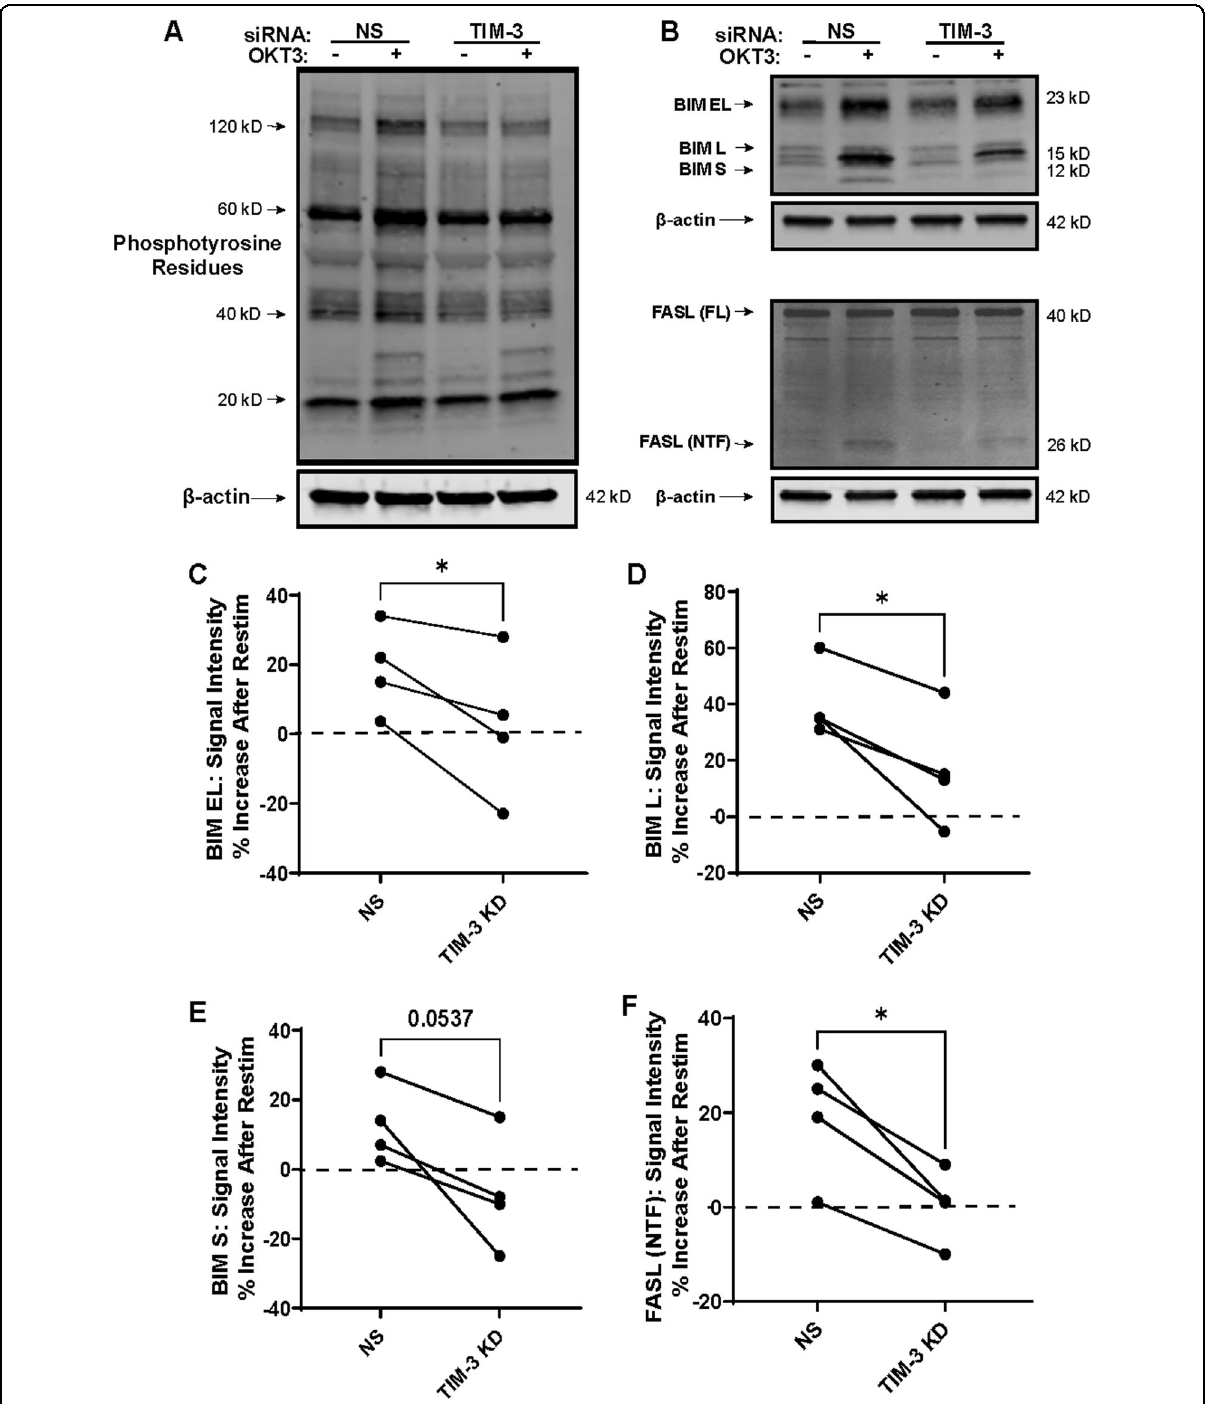
Fig. 2 TIM-3 drives increased proximal TCR signaling and pro-apoptotic protein expression in late-stage effector CD8 + T cells. A Representative phosphotyrosine western blot of late-stage lysates following TIM-3 knockdown and restimulation with 100 ng/mL of OKT3. The blot represents 1 of 3 that were run from individual donors. B Western blots for BIM isoforms (EL = extra-long isoform, L = long isoform, S = short isoform) and Fas Ligand (FASL, FL = full-length, NTF = N-terminal fragment). Beta-actin serves as a loading control. C – F Differences in protein expression were assessed for statistical signi fi cance using spot densitometry, normalized to actin. Each connecting line represents a single donor. Asterisks denote statistical signi fi cance using the following paired t tests: C p = 0.0480, D p = 0.0265, E p = 0.0537, F p =